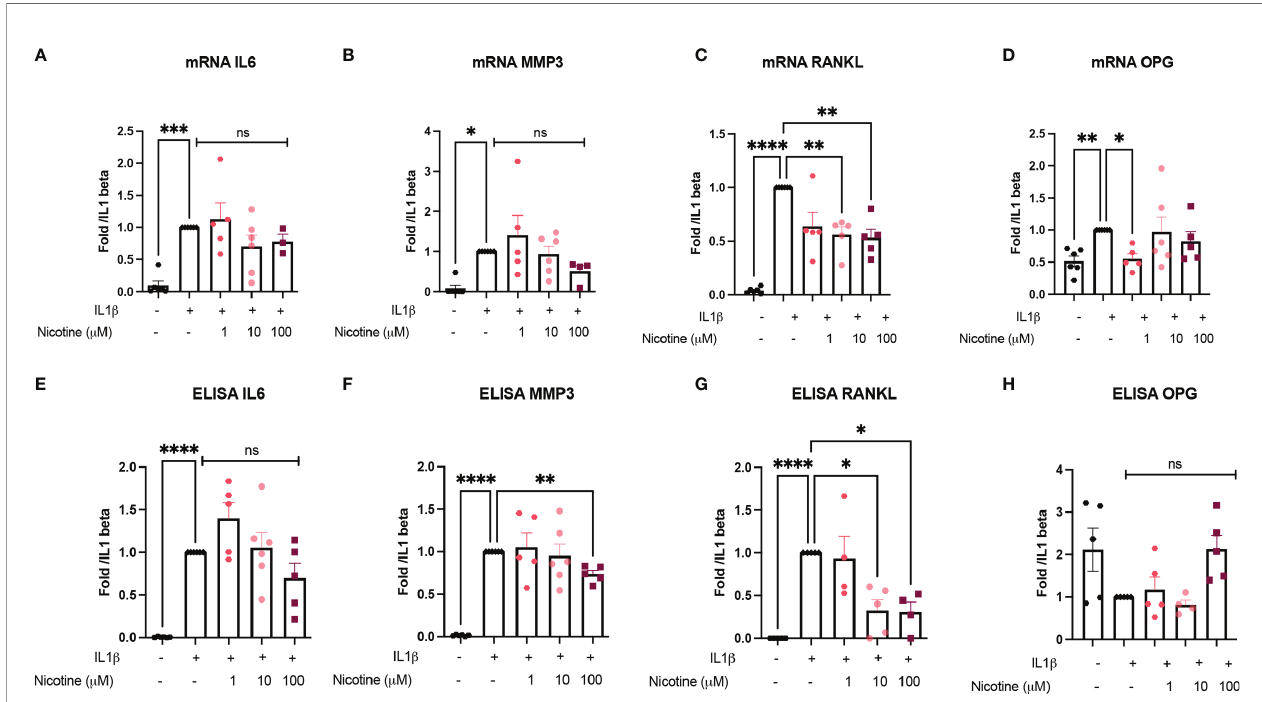
FIGURE 2 | a7nAchR is involved in anti-in fl ammatory and anti-catabolic response in vitro but not bone remodeling marker. (A) IL6, (B) MMP3, (C) RANKL, and (D) OPG mRNA expression by Chrna7 -/- OB pretreated with 1, 10, or 100 µM nicotine for 15 min and stimulated with 10 ng/ml IL1 b for 24 h ( n = 5 for Chrna7 -/- , * p < 0.05 using one-way ANOVA with Dunnett post-test). The results are normalized to the IL1 b condition. ELISA results of (E) IL6, (F) MMP3, (G) RANKL, and (H) OPG in Chrna7 -/- OB pretreated with 1, 10, or 100 µM nicotine for 15 min and stimulated with 10 ng/ml IL1 b for 24 h ( n = 5 for WT, * p < 0.05 using RM one-way ANOVA with Dunnett post-test). The results are normalized to the IL1 b condition. *p<0.05, **p<0.01, ***p<0.001,